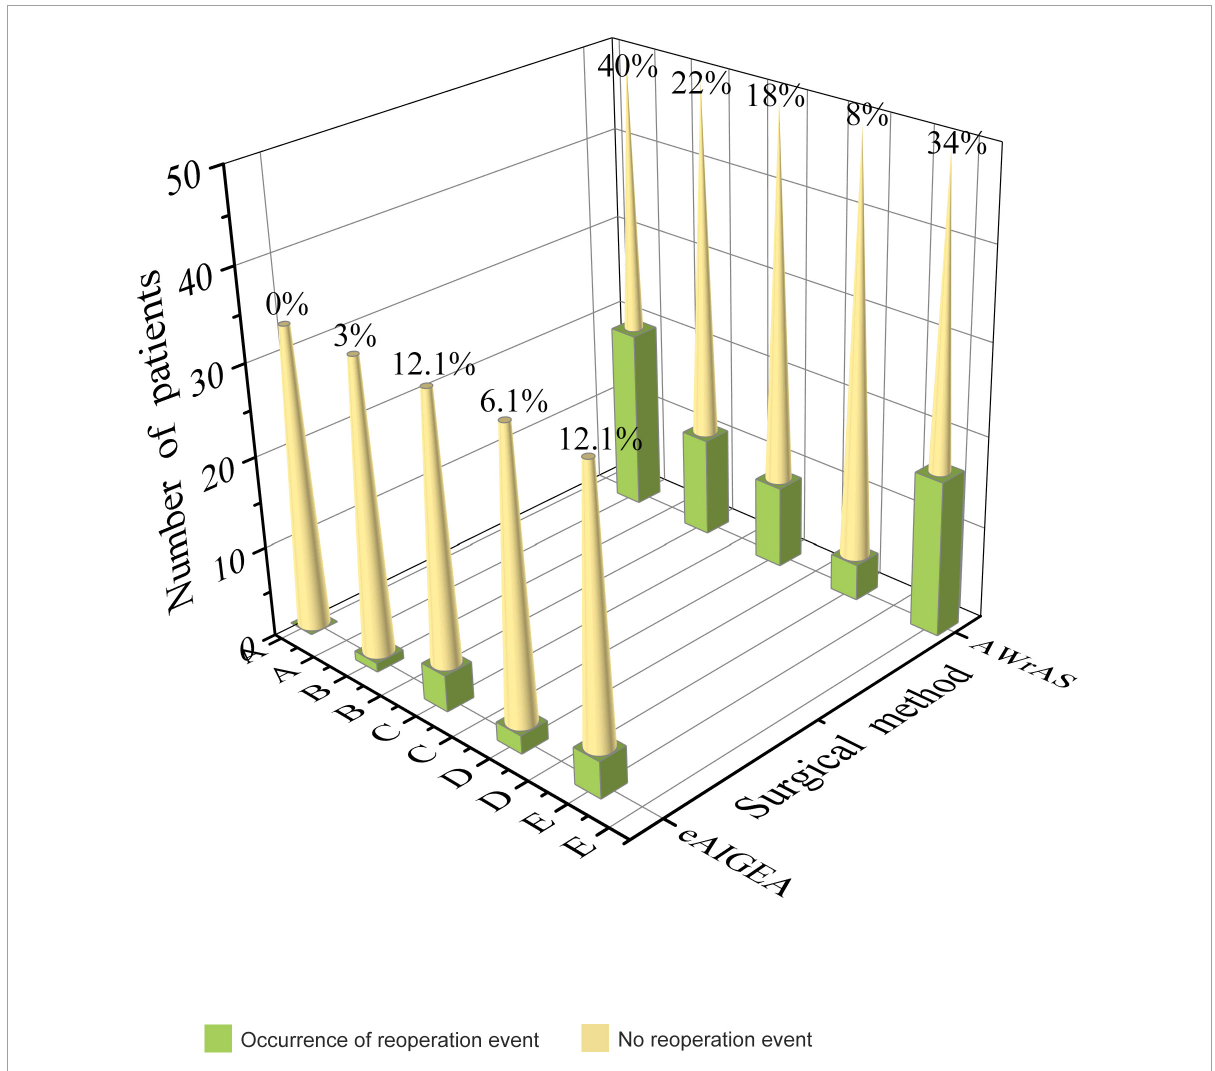
FIGURE4 Reoperation-related events: A) recurrence of the false lumen in the aortic root dissection ( P < 0.001), B) anastomotic leakage of the aortic root ( P = 0.016), C) pericardial effusion of moderate volume or above ( P = 0.471), D) a mediastinal infection or infective endocarditis ( P = 0.738), E) progression of aortic valve regurgitation during the follow-up compared with that after surgery ( P =